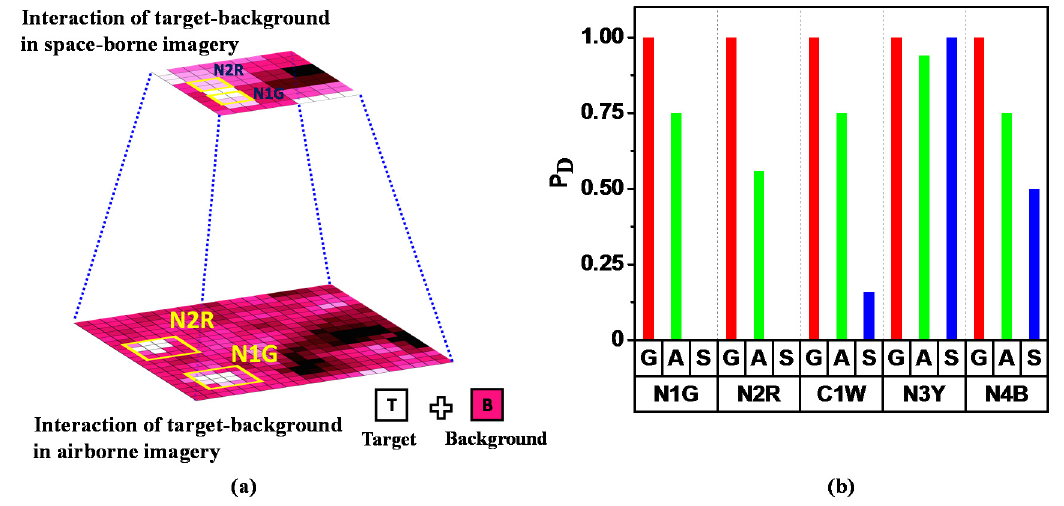
Figure 21. ( a ) Visualization of the non-linear interaction of background signal with the target spectrum for the N2R and N1G targets, and ( b ) best case target detection continuum results of detection performance across imagery from all the platforms (G-ground, A-airborne, S-space-borne) for all the targets used in at a false alarm rate of 10 − 3 for the in-situ target reference spectra.